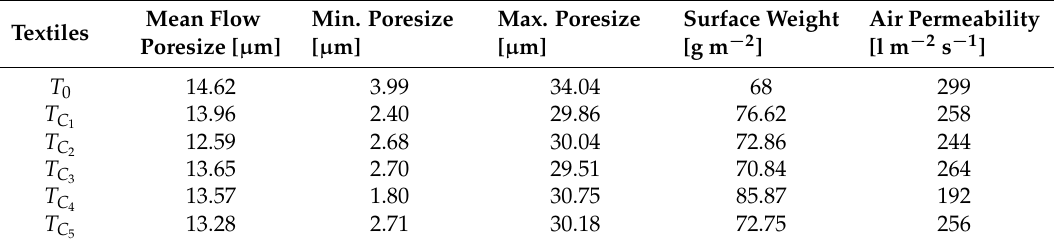
Table 5. Textile properties of the reference material and the equipped